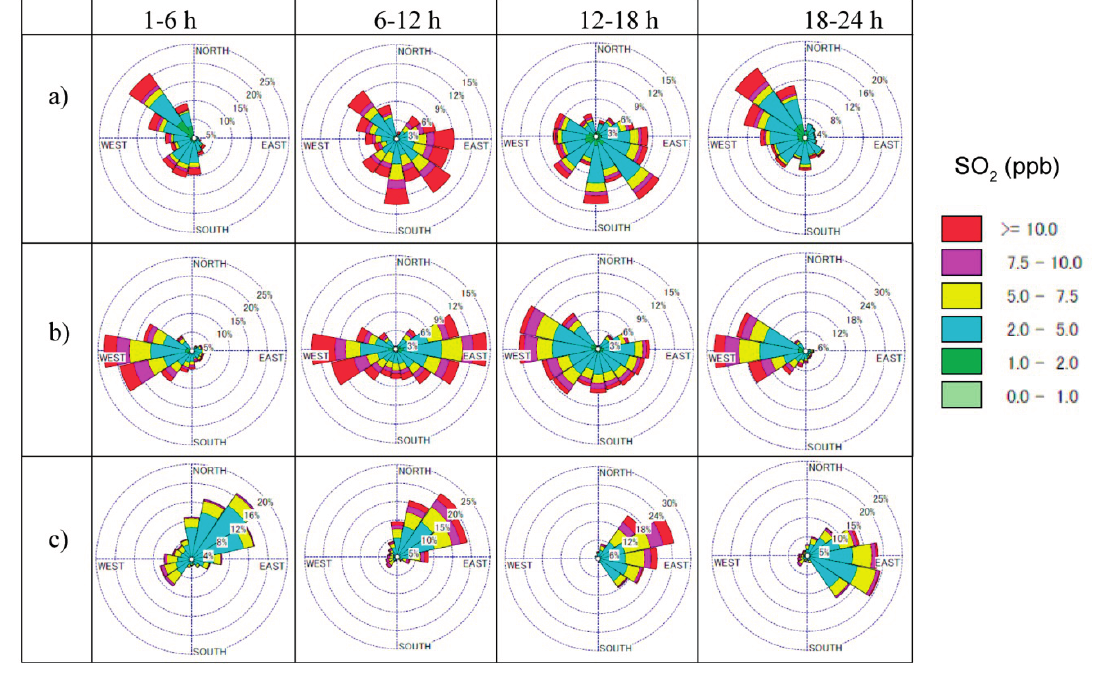
Hours are referred as